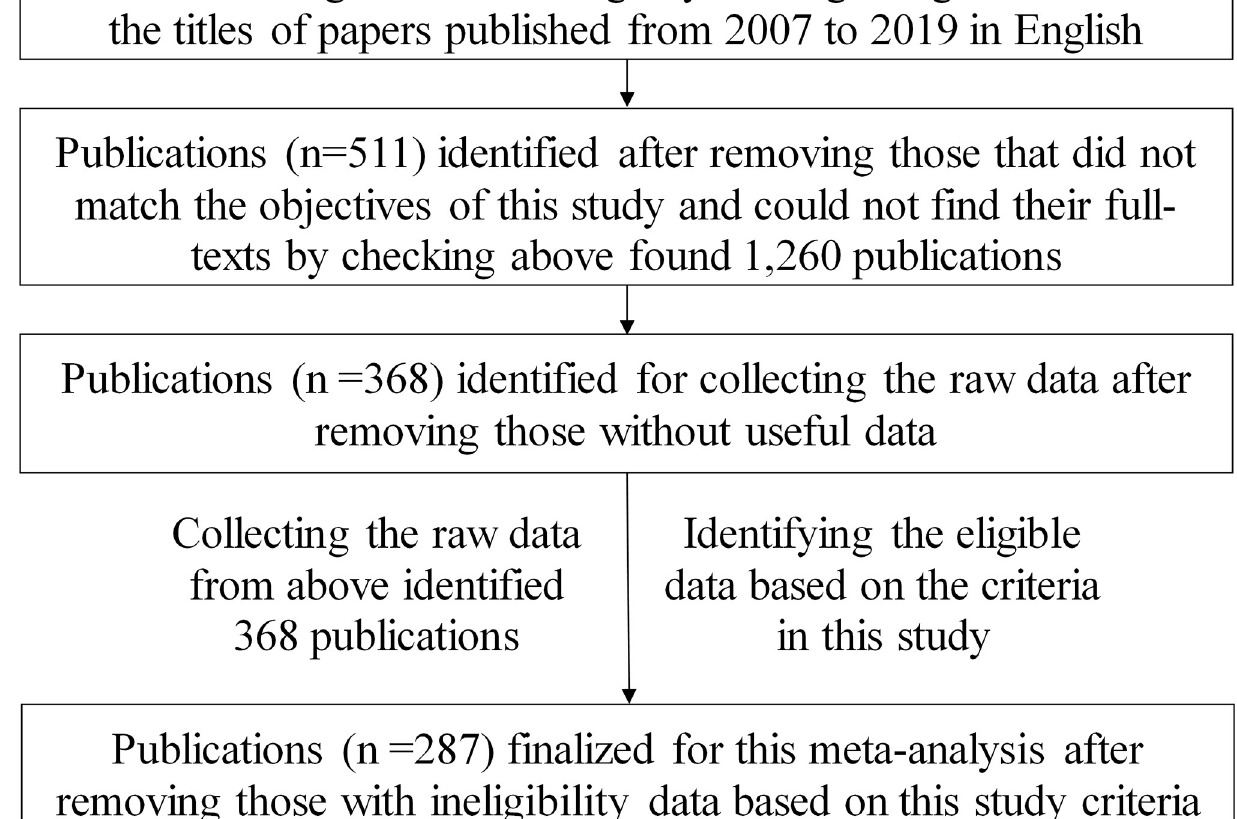
Fig 1. A flow diagram showing the process and methods for publication search and data collection in this meta-analysis.